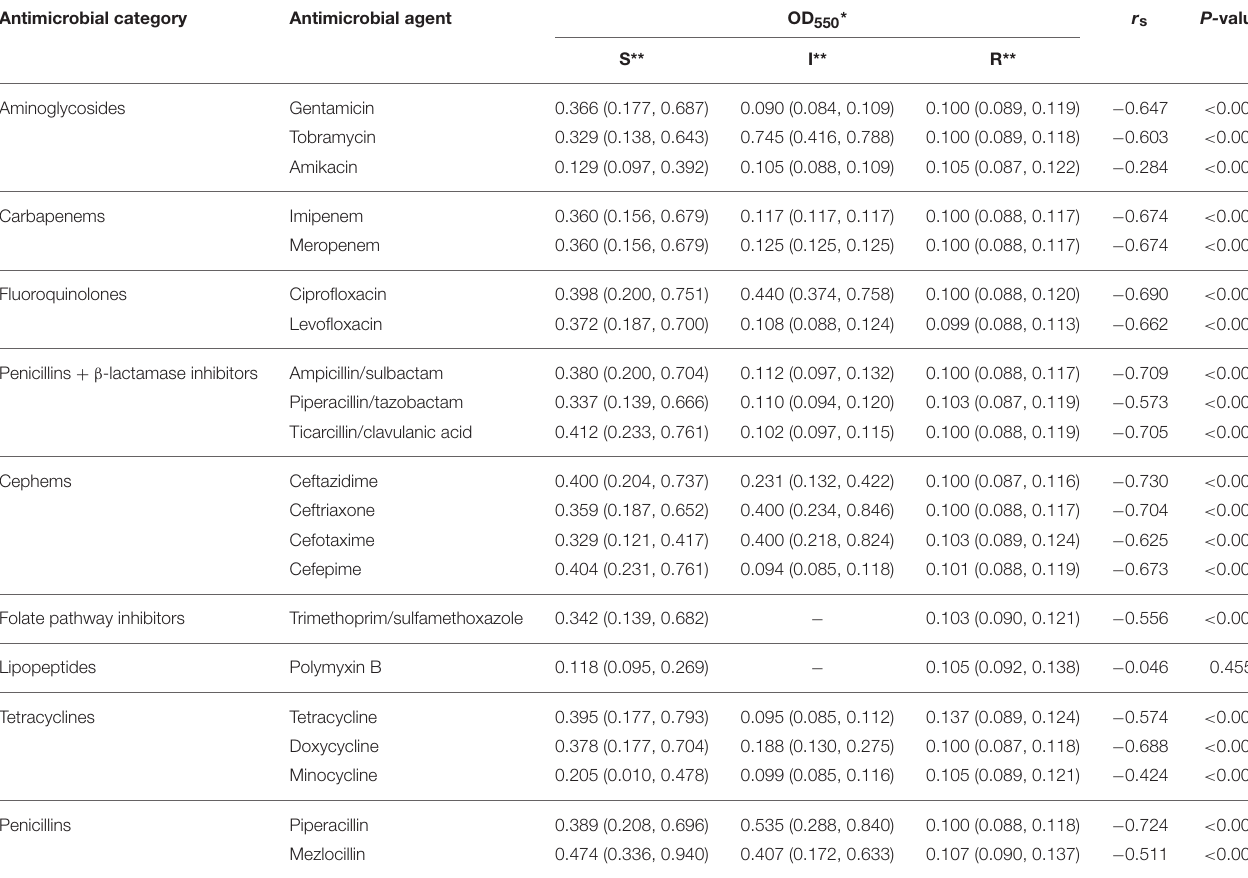
TABLE 2 | Correlation between the level of biofilm formation and resistance to 21 antibiotics in A. baumannii clinical isolates. Antimicrobial